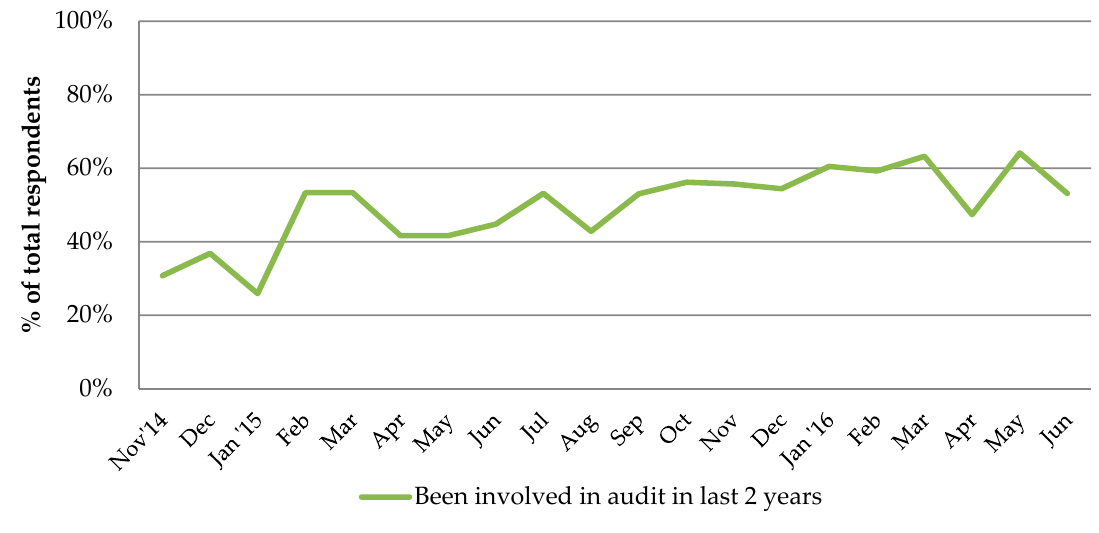
Figure 2. Percentage of respondents involved in an antibiotic audit during last two years.